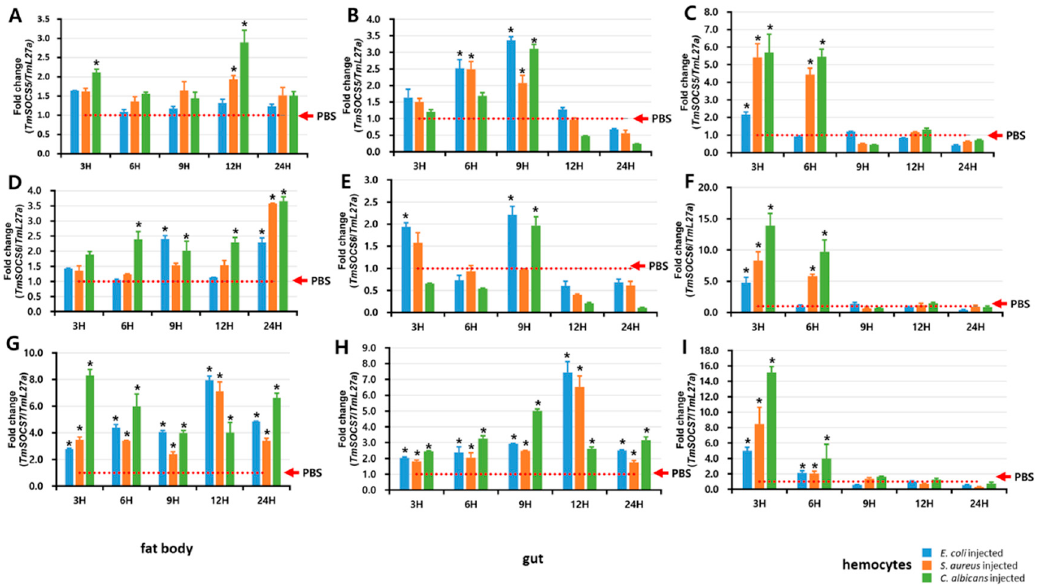
Figure 10. Expression of TmSOCS5, TmSOCS6, and TmSOCS7 mRNA in the fat body ( A , D , G ), gut ( B , E , H ), and hemocytes ( C , F , I ) of T. molitor following challenge with E. coli , S. aureus , and C. albicans . Expression was analyzed by real-time PCR using RpL27a as the control for normalization. For each time point, the expression level in the PBS-injected control was set to 1, and this is represented by a dotted line. Values are the mean of three independent measurements ± S.E. ( n = 3). * p < 0.05.